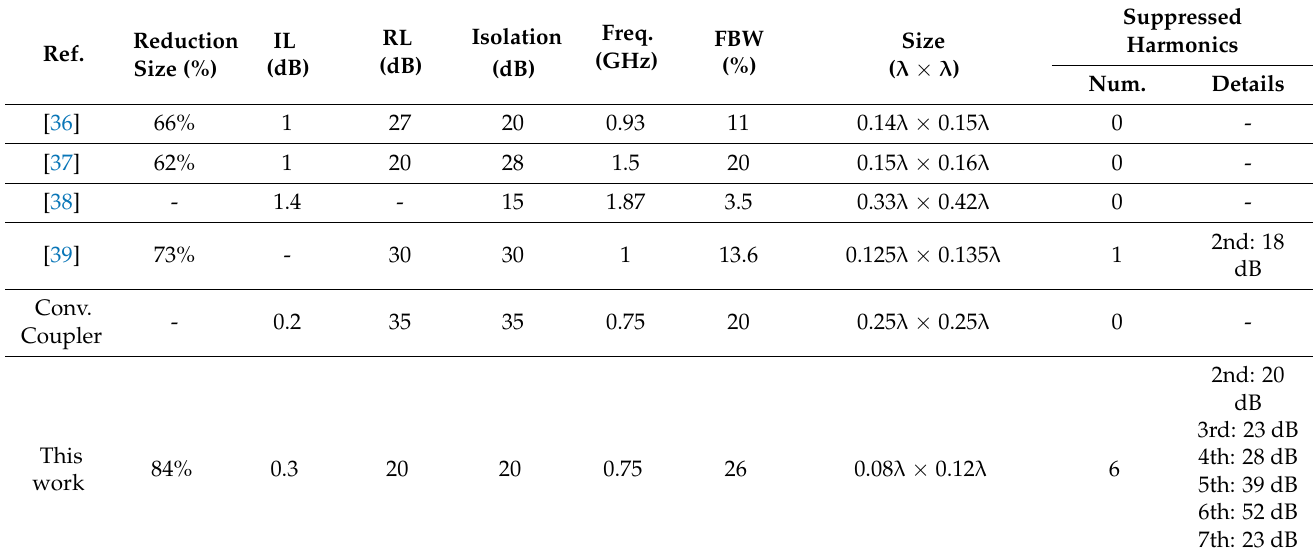
Table 3. Performance comparison between the final prototype of the designed coupler and some related